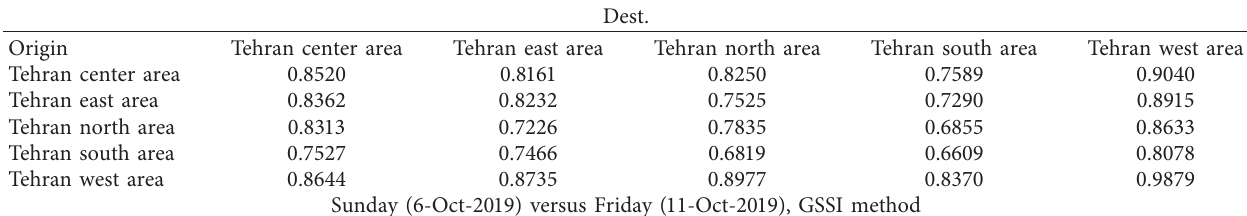
Table 5: SSIM obtained from GSSI for Sunday in comparison with weekend.